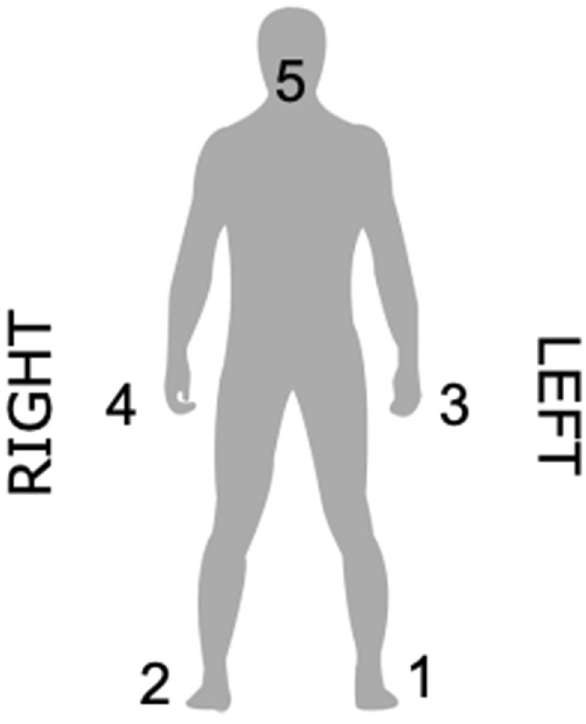
Figure 1. Elements of the proposed bodily hierarchy for right-handed people. (5) voice, (4) right hand, (3) left hand, (2) right foot, (1) left foot. The figure was created using Adobe Illustrator 2018 22.0.0 (https:// www. adobe. com/ produ cts/ illus trator. html) and Microsoft Word for Mac, version 16.49 (21050901) (https:// www. micro soft. com/ da- dk/ micro soft- 365/ word).